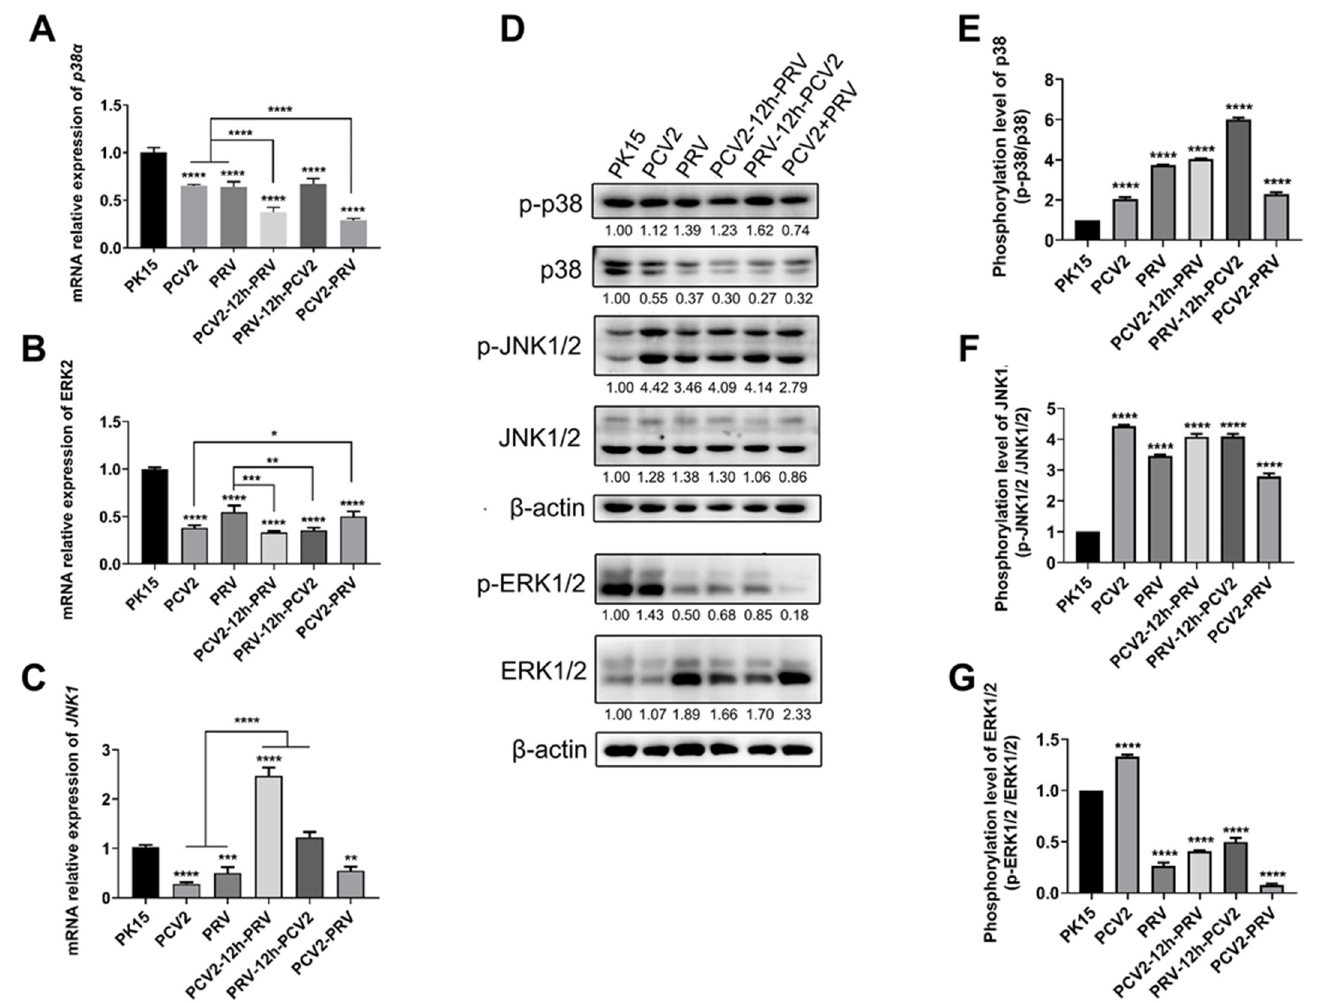
Figure 8. Coinfection of PCV2 and PRV activates inflammatory and immune responses via p38 and JNK1/2 . ( A – C ) Expression levels of MAPKs. The relative mRNA levels of p38 ( A ), ERK1/2 (B), and JNK1/2 ( C ) were examined via real-time PCR. The data are presented as the means ± SD. *, p -value < 0.05; **, p -value < 0.01; ***, p -value < 0.001; ****, p -value < 0.0001. ( D – G ) Protein levels of MAPKs. Western blotting was conducted using p-p38 (Thr180/Tyr182), P38, JNK (FL), p-JNK (Thr 183/Tyr 185), ERK p44/42 MAPK (Erk1/2) (137F5) Rabbit mAb, Phospho-p44/42 MAPK (Erk1/2) (Thr202/Tyr204) (D13.14.4E) XP ® Rabbit mAb, and Anti- β -Actin Antibody as primary antibody,